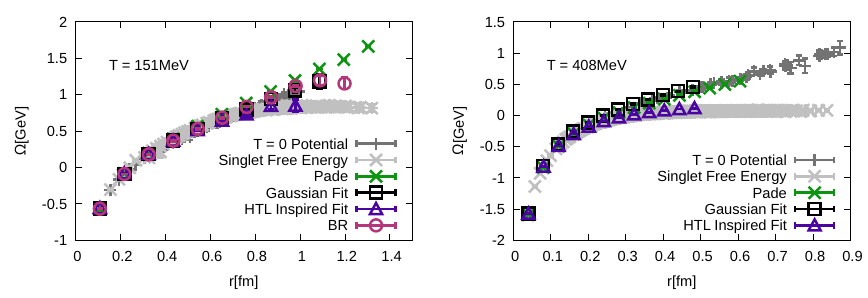
Figure 1. Extracted values of Ω at T = 151MeV (left) and at T = 408MeV (right) according to the four complementary methods used in [18]. Singlet free energies are shown in light gray and the T = 0 potential in dark gray.